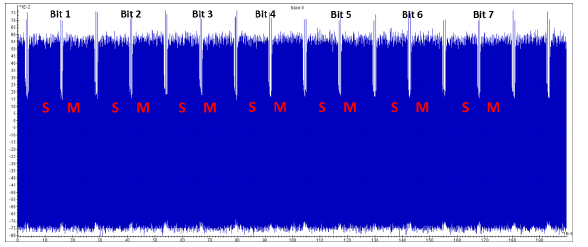
Figure 3: Sequence of MMM processings for the first MSBs of the exponent.